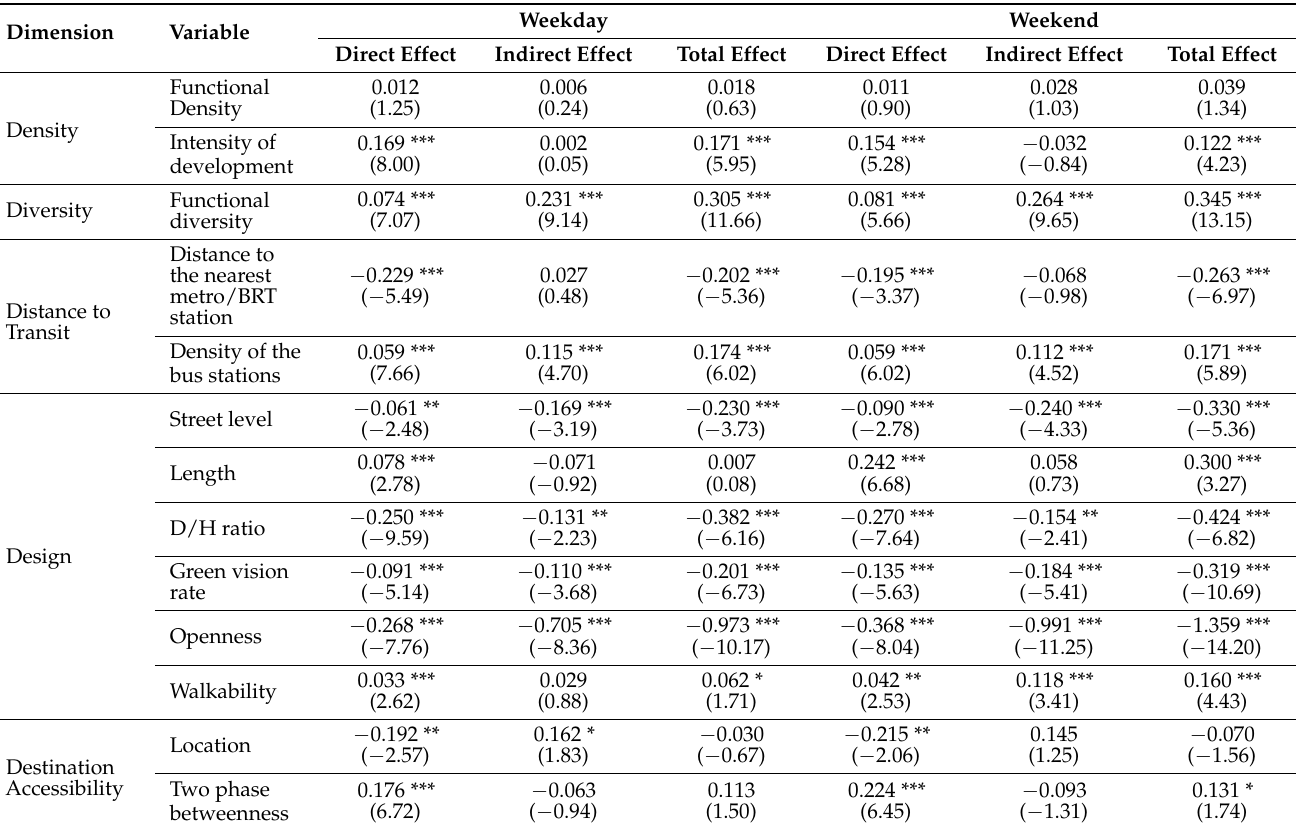
Table 4. Decomposition results of the influence of the built environment on the street